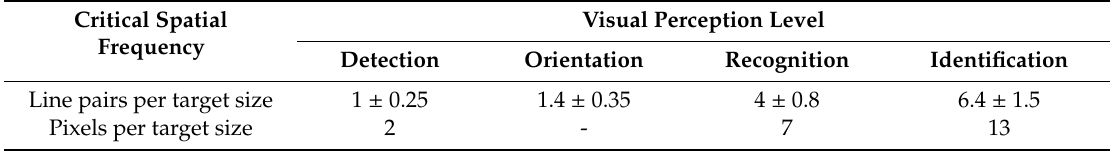
Table 3. Visual perception levels versus critical spatial frequency, as defined by Johnson’s